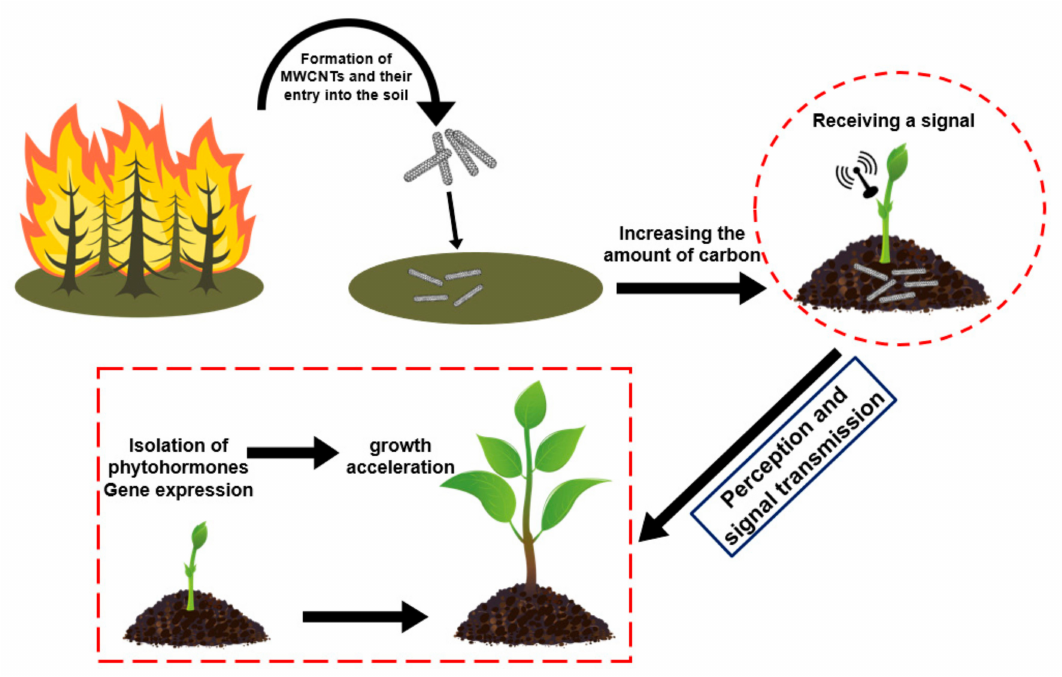
Figure 10. Possible process of the influence of MWCNTs on the synthesis of secondary